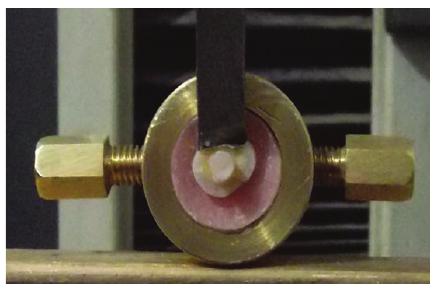
Figure 1: Sample secured to the lower fixed compartment of testing machine by tightening